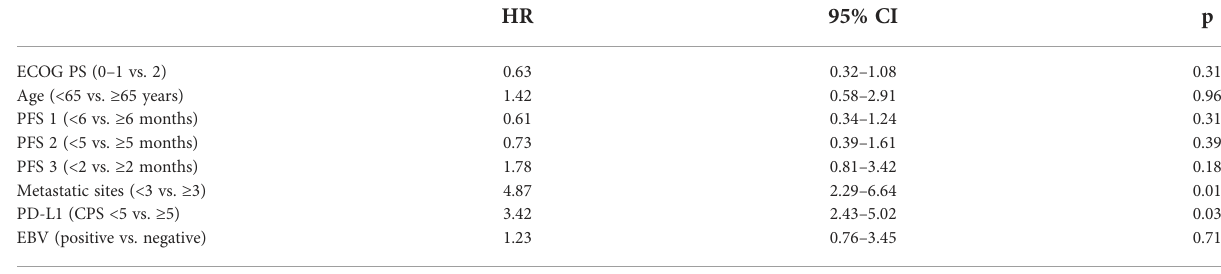
TABLE 4 Adverse events. Hematologic Neutropenia Anemia Thrombocytopenia